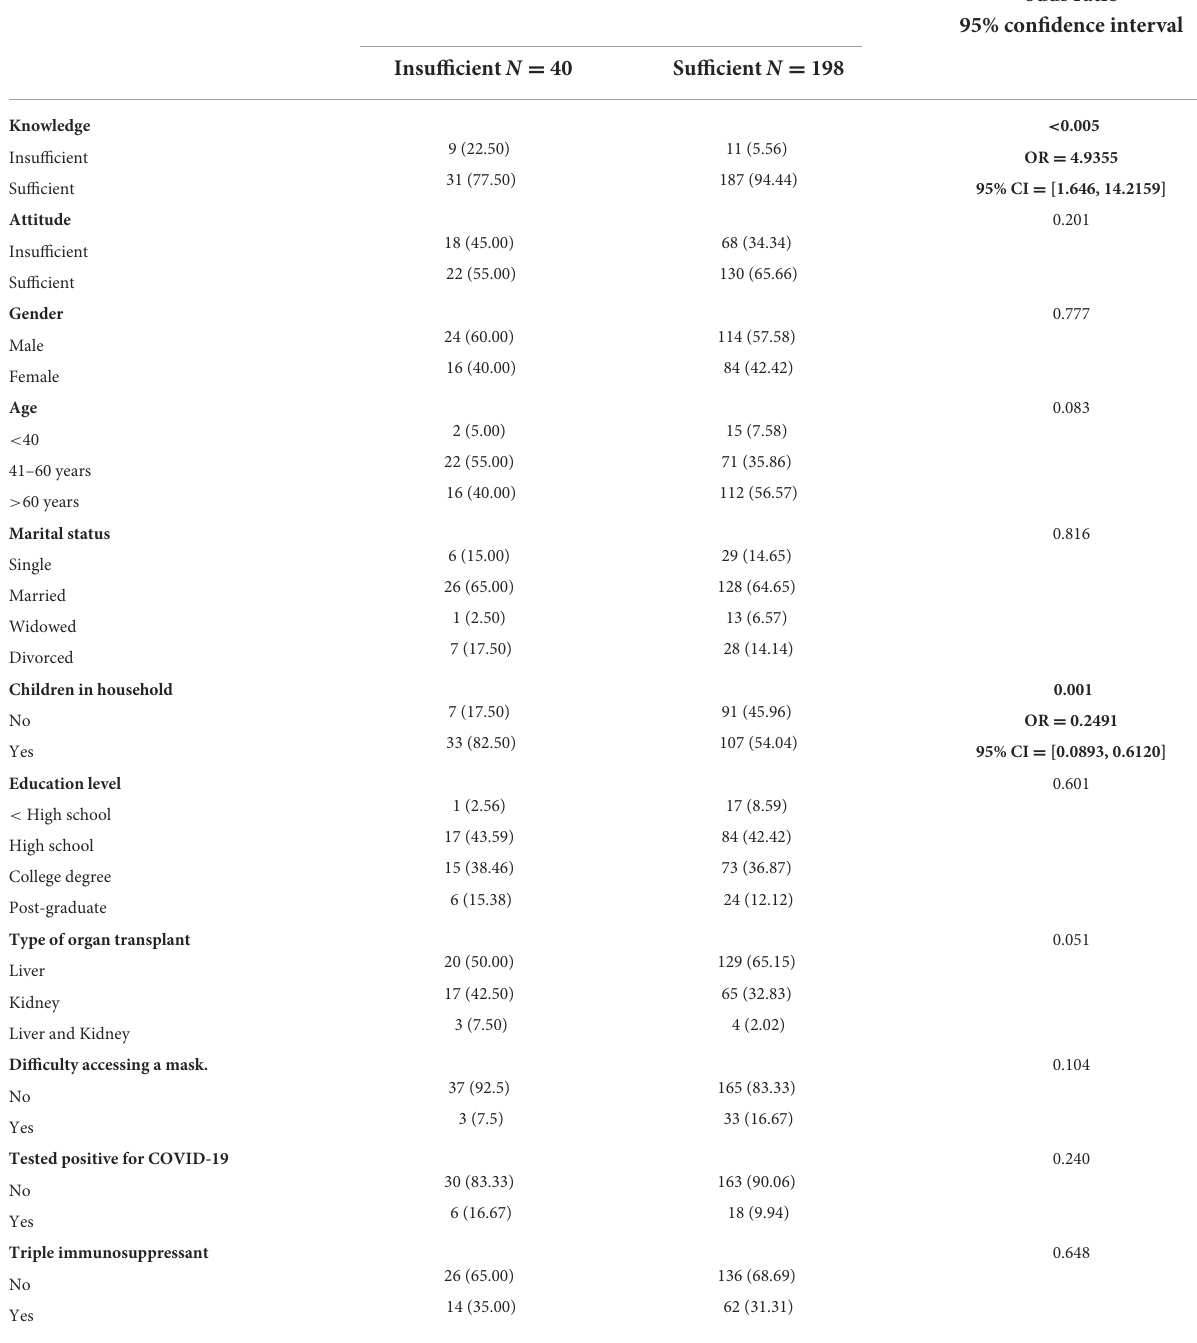
TABLE 5 Sociodemographic determinants of sufficient practice